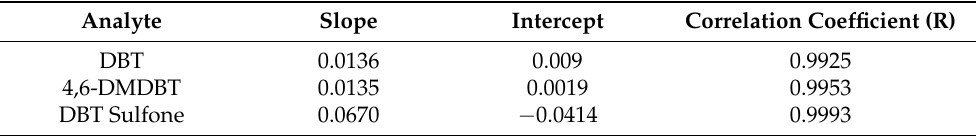
Table 1. Linearity data of developed method.